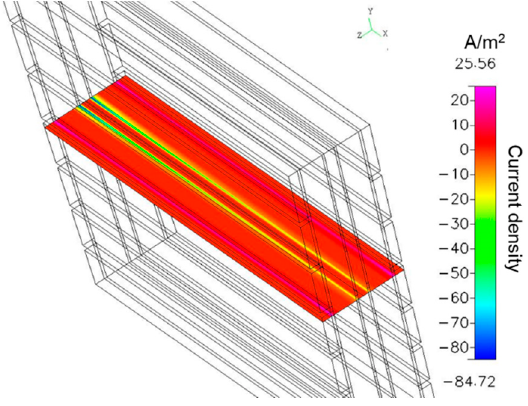
Figure 6. Current density contours in the mid ‐ cross ‐ sectional ( x ‐ z ) plane.